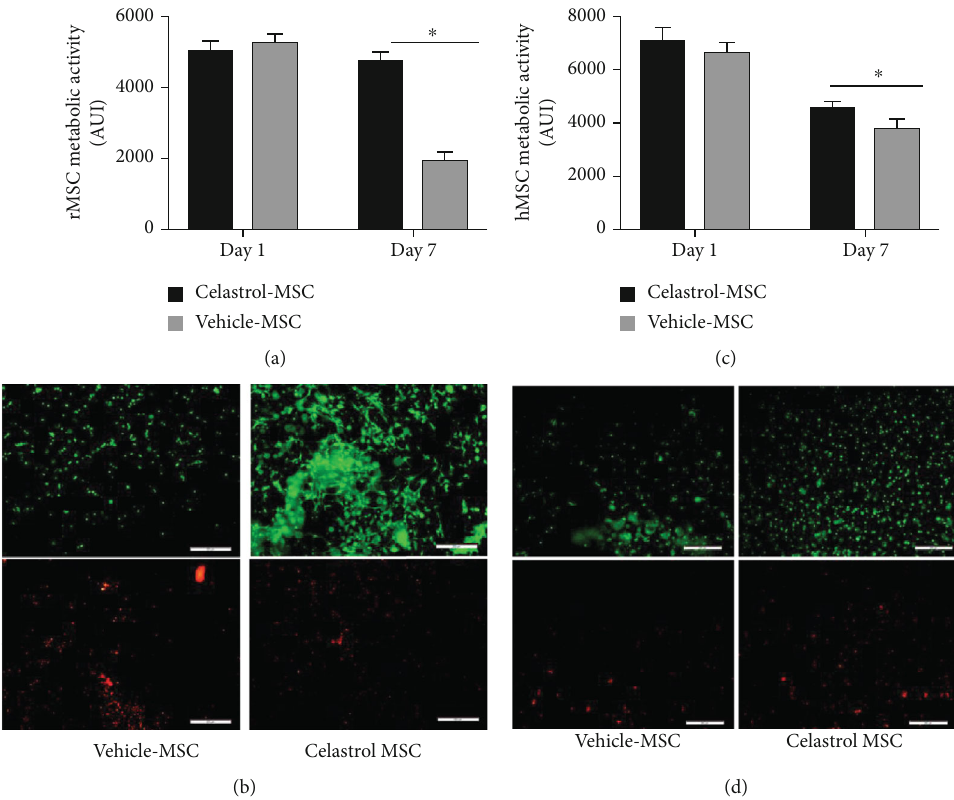
Figure 2: Celastrol increases viability of encapsulated MSC in normal medium: (a) metabolic activity at days 1 and 7 of rat MSC preconditioned with celastrol 1 μ M or vehicle (DMSO 0.1% v / v ), mean ± SEM ; b) live/dead pictures taken at day 7; n = 8 , N = 3 ; (c) metabolic activity at days 1 and 7 of human MSC preconditioned with celastrol 1 μ M or vehicle, mean ± SEM , n = 14 , N = 5 ; (d) live/dead pictures taken at day 7 (viable cells: green, dead cells: red, scale bar 200 μ m); ∗ p < 0 : 05 versus the vehicle at the same time